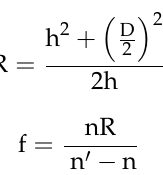
where h and D are the height and diameter of the spherical microlens structure prepared in the experiment, respectively, and n and n (cid:48) are the refractive indices of air (n = 1) and the material (n (cid:48) = 1.515), respectively. The variables h and D are known to be 20 µ m and 180 µ m, respectively; the radius of curvature R is 212.5 µ m, and f is 412.6 µ m, where the radius of curvature R and radius obtained by fitting are in good